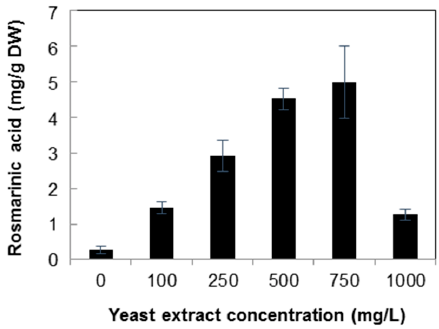
Figure 6. Content of rosmarinic acid in Agastache rugosa callus treated with various concentrations of yeast extract for 72 h. The levels of rosmarinic acid from each sample were analyzed by high performance liquid chromatography (HPLC). Error bars show standard deviation values. DW, dry weight.